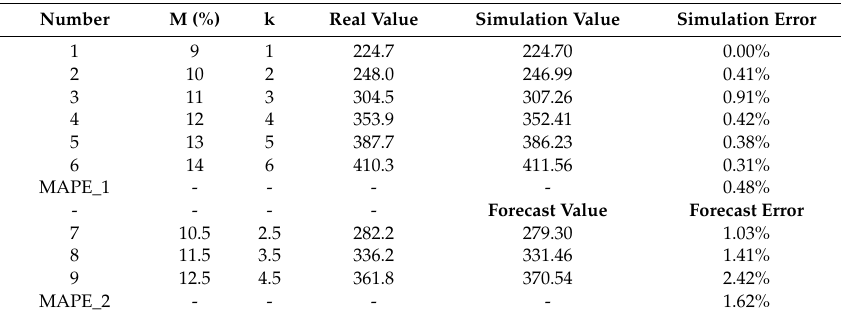
Table 4. Improved DNGM(1,1) model results.